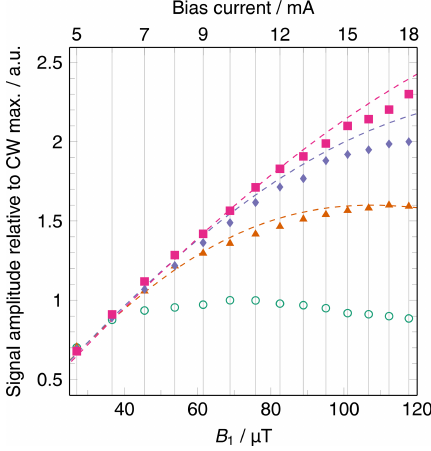
Figure 3. RS-EPRoC time traces (black) recorded using four dif- ferent bias currents that correspond to four different B 1 magnitudes at a scan rate of 80THzs − 1 . The spin system passes through res- onance twice during each period of the modulation of the MW frequency; see Eqs. (6) and (7). The simulations (orange) of the transient-acquired data are in good agreement with the experiment.